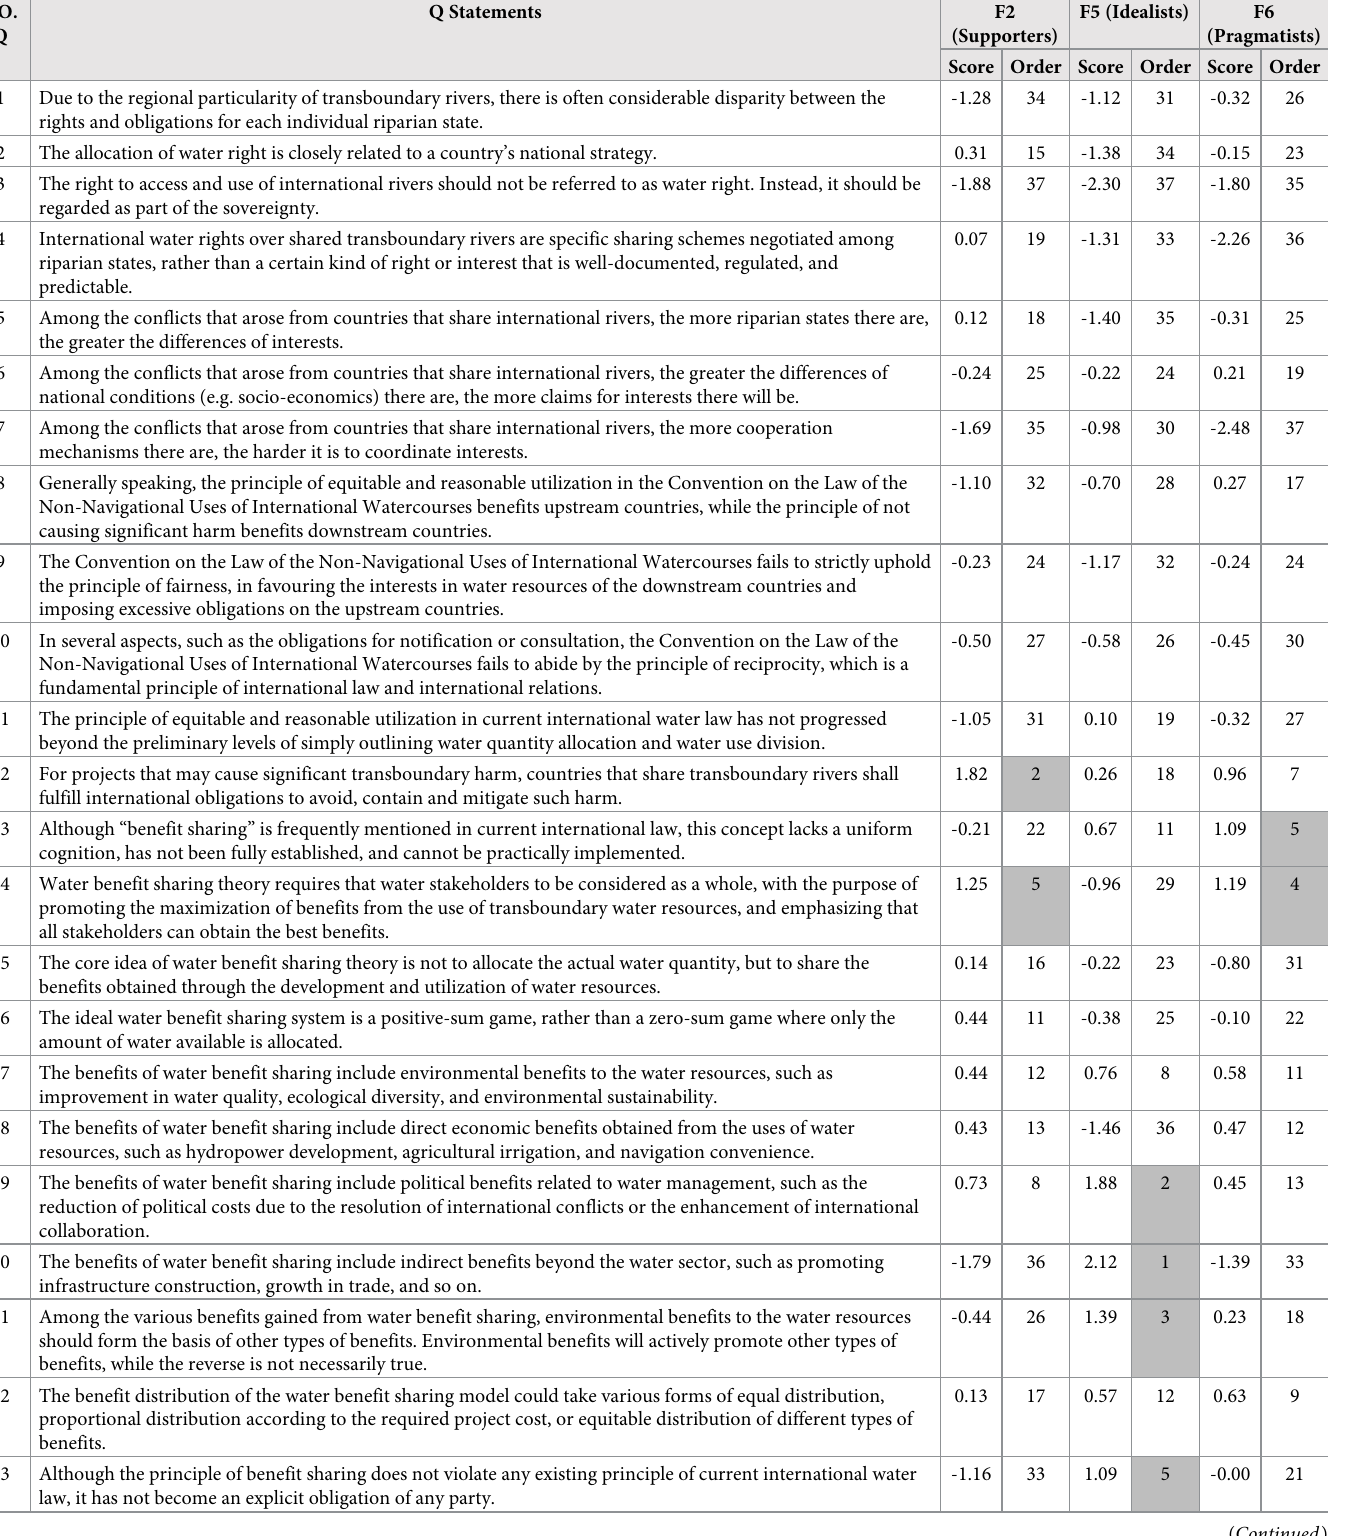
Table 2. Opinions of Q statements by perspective grouping (shaded cells highlight the five most strongly supported views of each groups). NO.